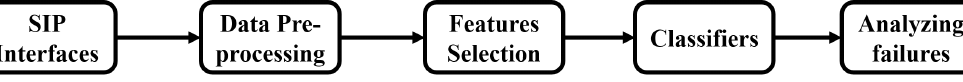
Figure 7. Proposed system model.